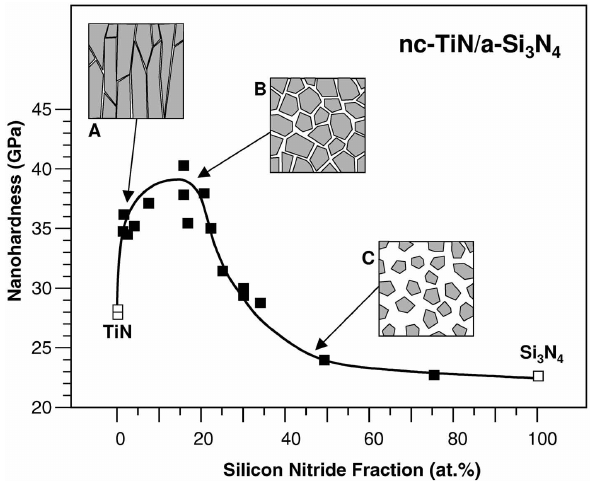
Figure 24: Hardness variation with Si % in Ti-Al-Si-N film